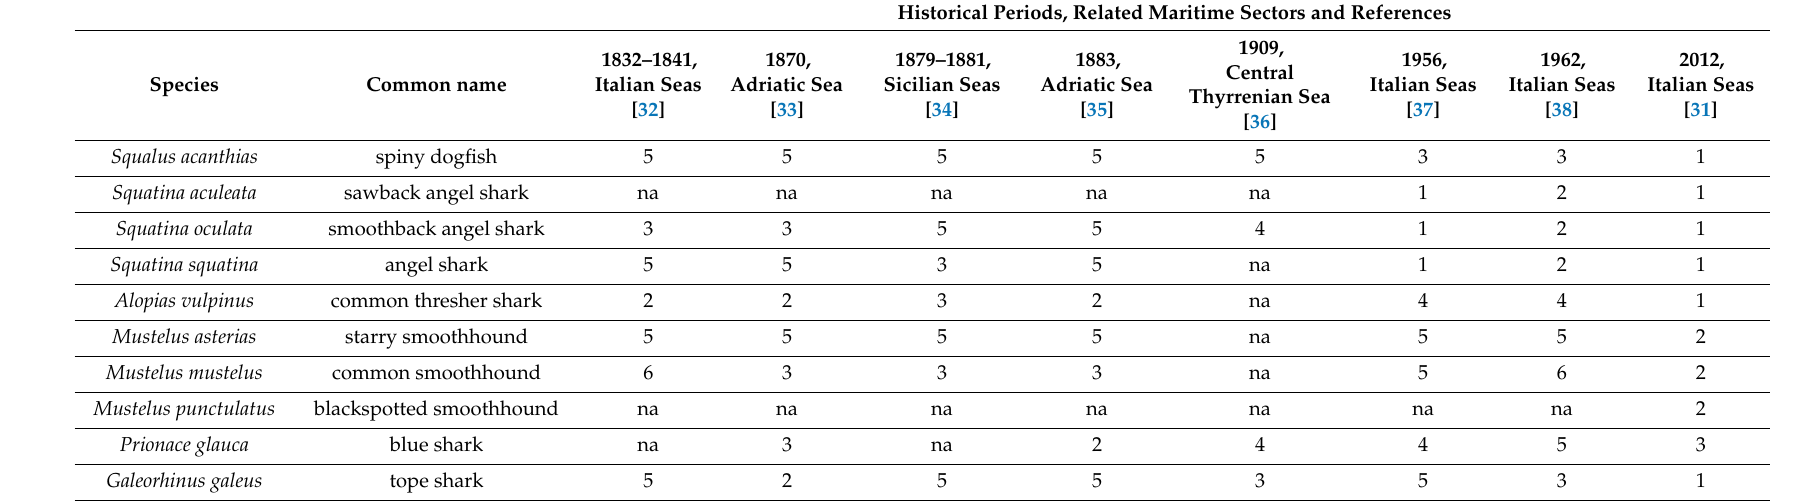
Table 3. References covering the selected shark species, with details on temporal range and related maritime